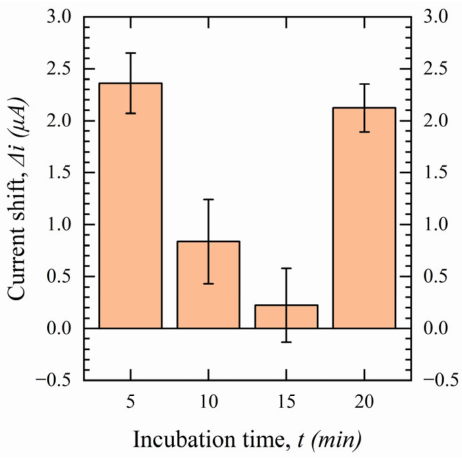
Figure 13. Effect of incubation time on sensor performance in subject’s filtered saliva ( n =